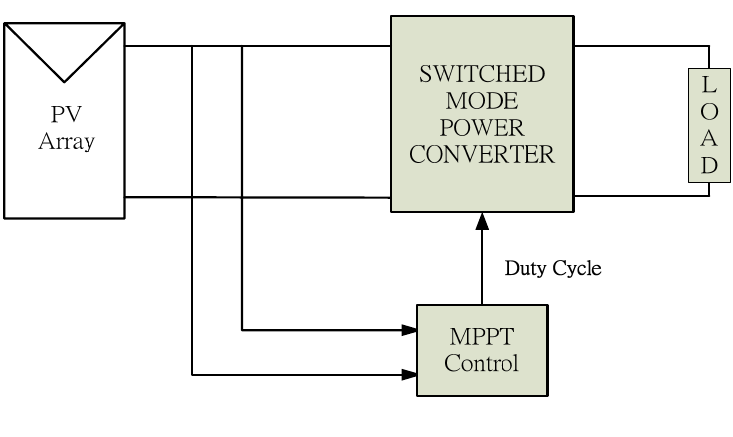
Figure 4. A block diagram of a PV control